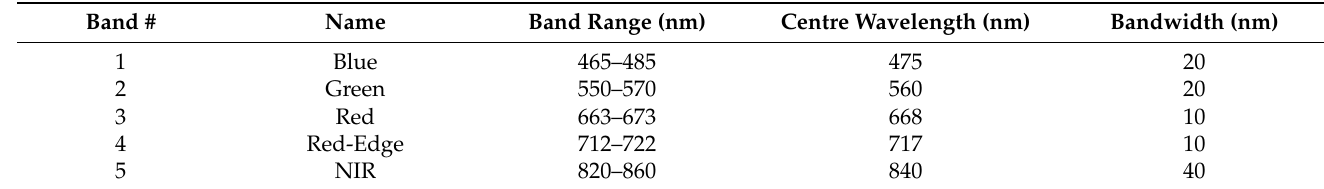
Table 2. Spectral characteristics of the five Micasense bands.